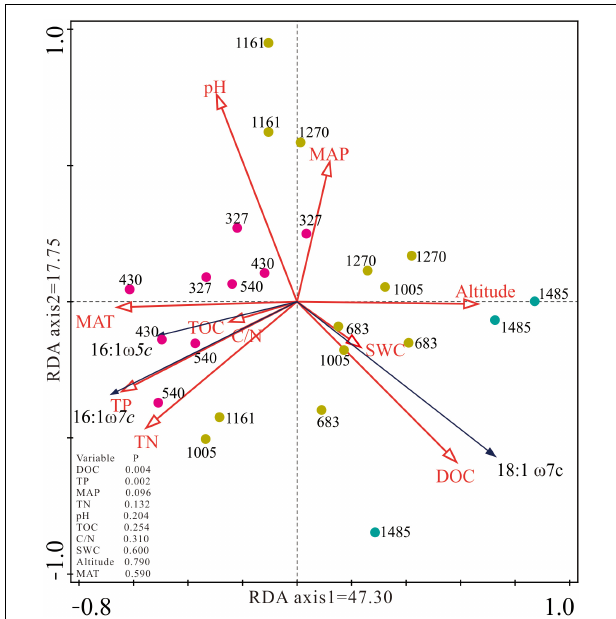
FIGURE 3 | Redundancy analysis (RDA) ordination plot of the concentration of 16:1 ω 7c, 16:1 ω 5c, and 18:1 ω 7c constrained by the altitude, climate, and soil environmental factors. MAT, mean annual temperature; MAP, mean annual precipitation; TOC, soil total organic carbon; DOC, dissolved organic carbon; TN, total nitrogen; TP, total phosphorus; C/N, carbon and nitrogen